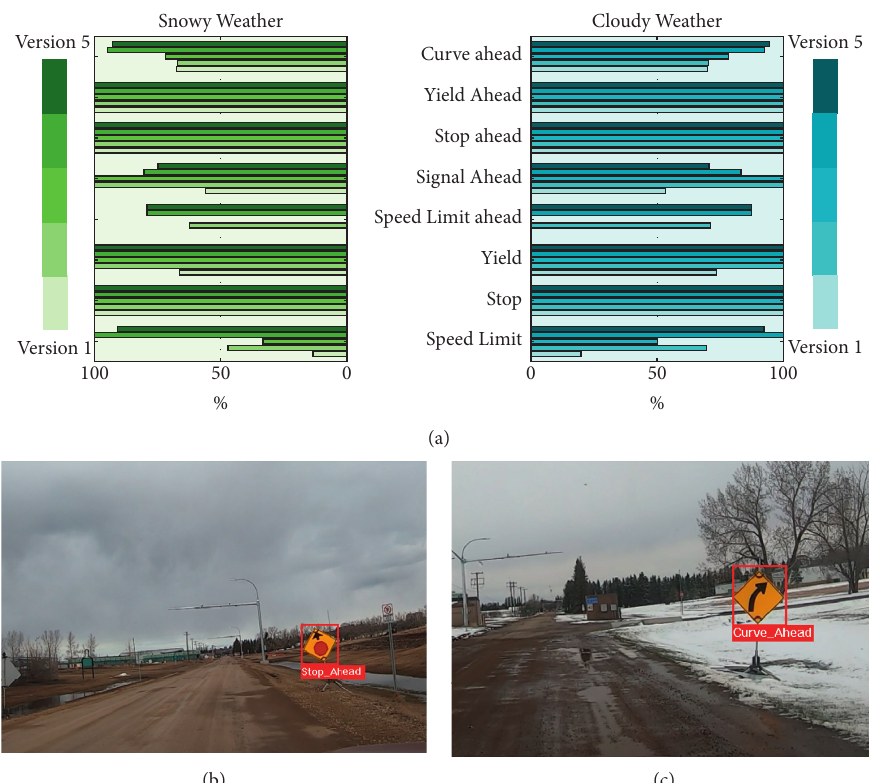
Figure 5: (a) Performance comparison in studied inclement weather scenarios and sample sign identification by the TSR system in (b) cloudy and (c) snowy weather.